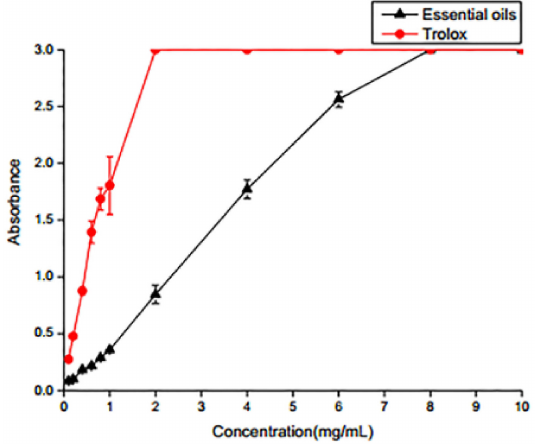
Figure 3. Iron ion reducing